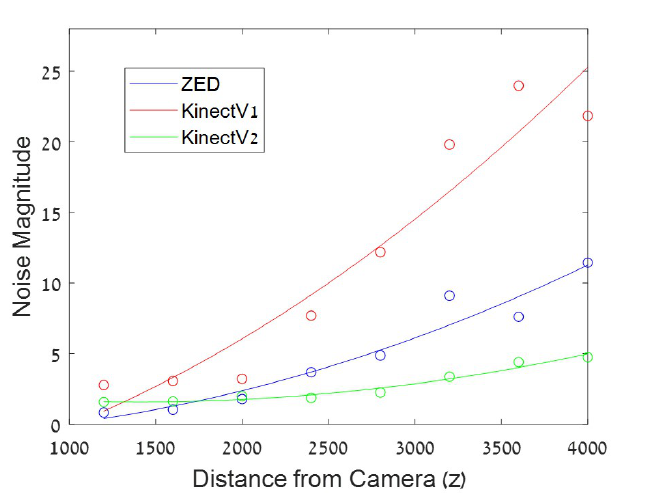
Figure 9. Camera noise at different distances from camera for three different camera types. Noise pattern differs significantly between